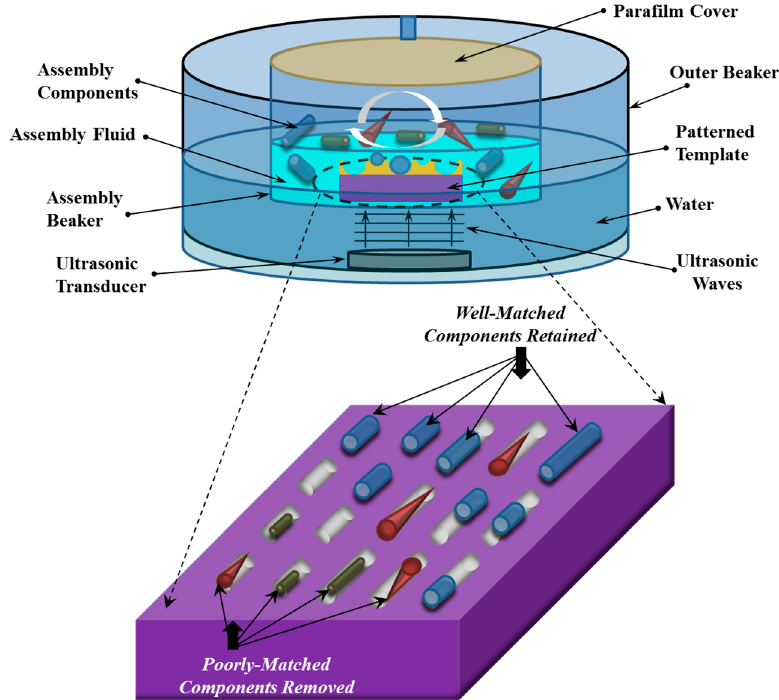
Figure 4. Conceptual diagram of the assembly set up (above), showing the assembly template and the microcomponents within the assembly beaker as well as the placement of the assembly beaker within an outer beaker that contains the high frequency ultrasonic transducer. The zoomed-in view (below) is a conceptual diagram of an assembly template during the assembly process. At the time shown, both well-matched and poorly-matched components have entered the assembly sites, and the poorly-matched components have not yet been removed by the selective removal mechanism.